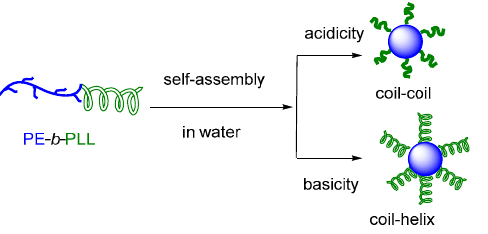
Scheme 2. The self-assembly of PE- b -PLL polymeric micelles in water.